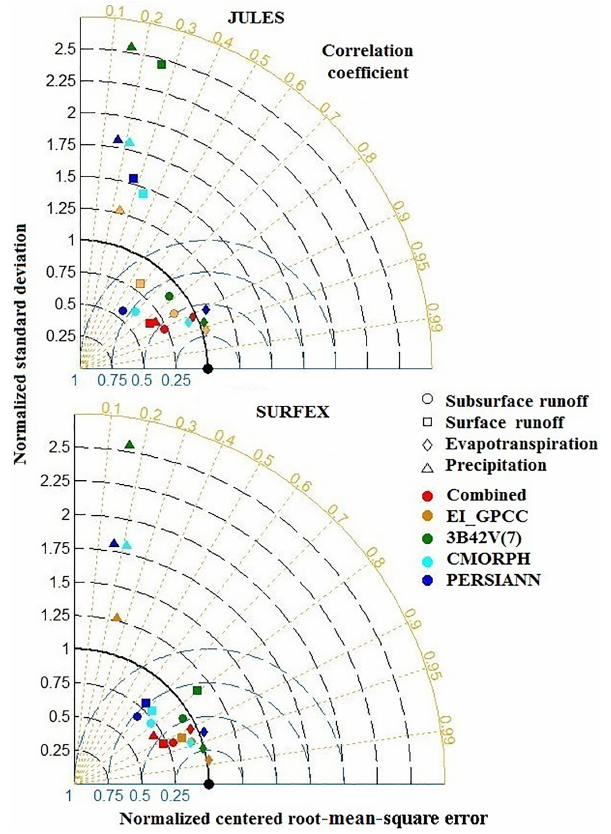
Figure 9. Normalized Taylor diagrams for 3-hourly precipitation and simulated hydrological variables based on SAFRAN and the satellite–reanalysis precipitation products used.